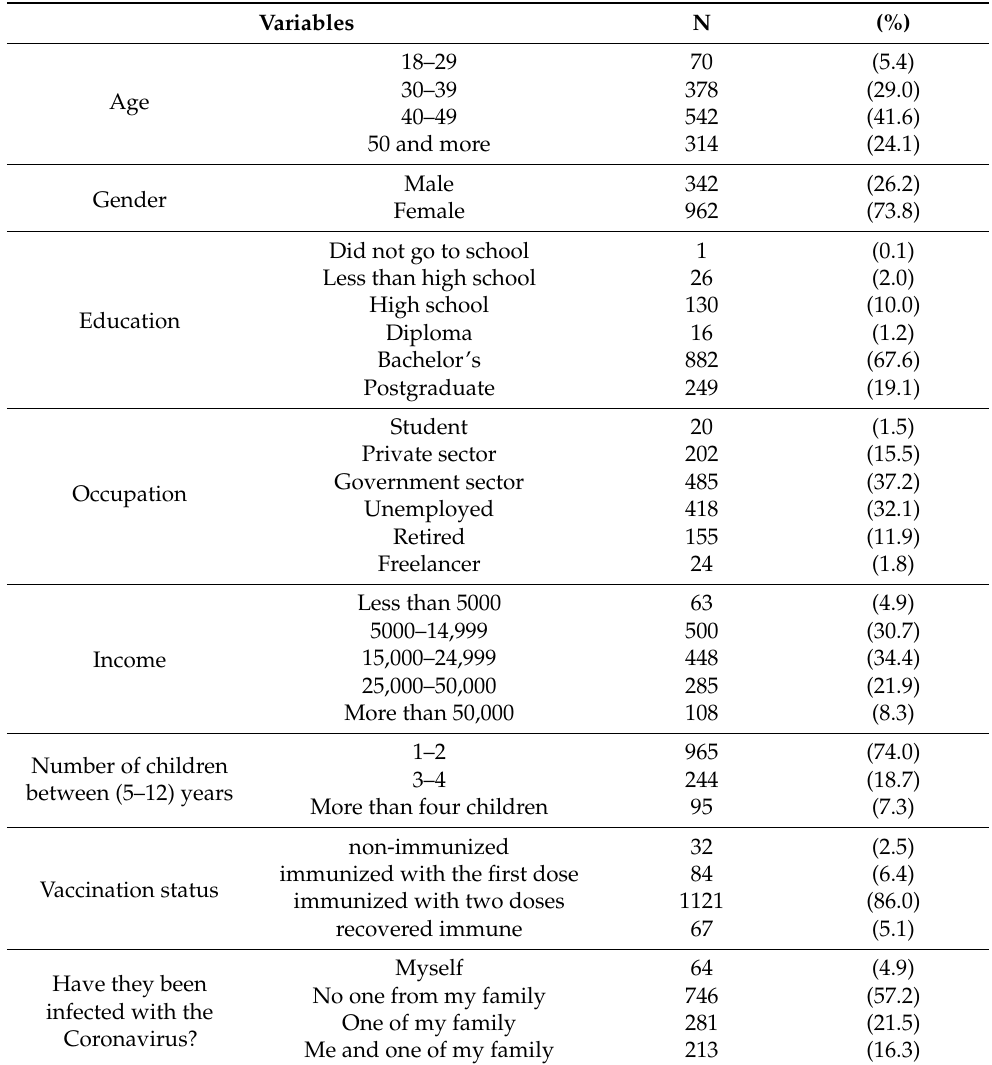
Table 1. Sociodemographic characteristics (n = 1304).